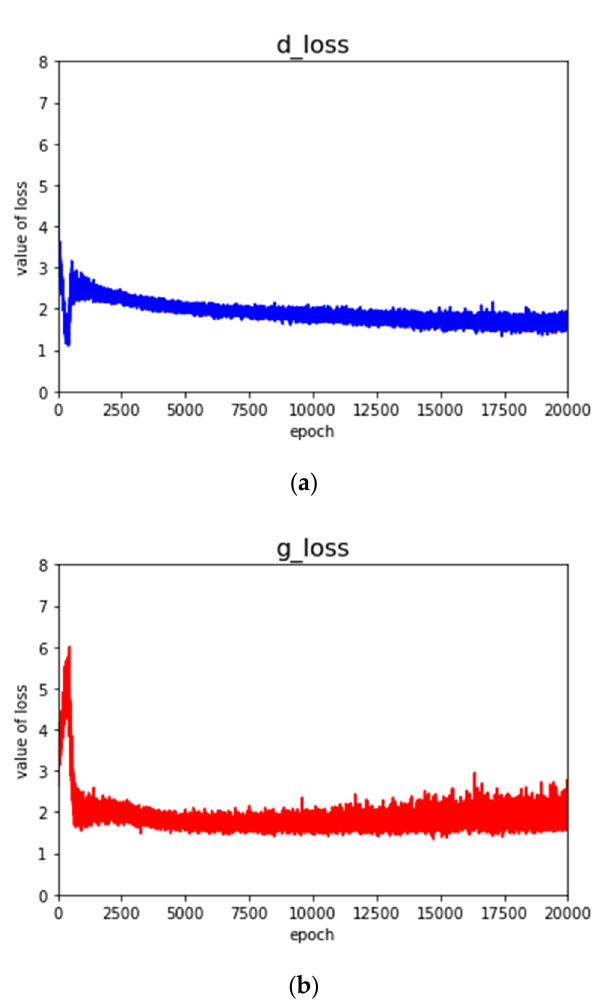
Figure 4. The curve of the loss function’ change. ( a ) Discriminator; ( b ) generator.